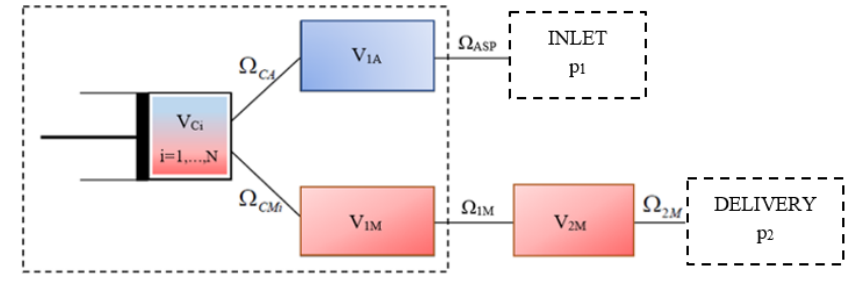
Figure 2. Volumes Figure 2. Volumes considered.